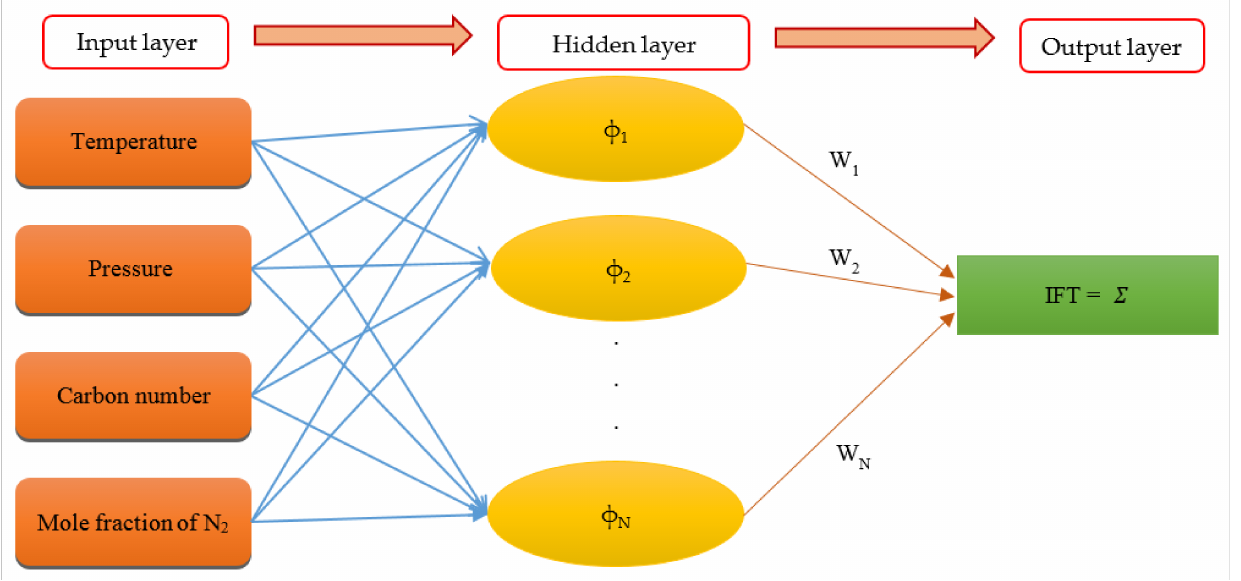
Figure 2. Schematic of a RBF